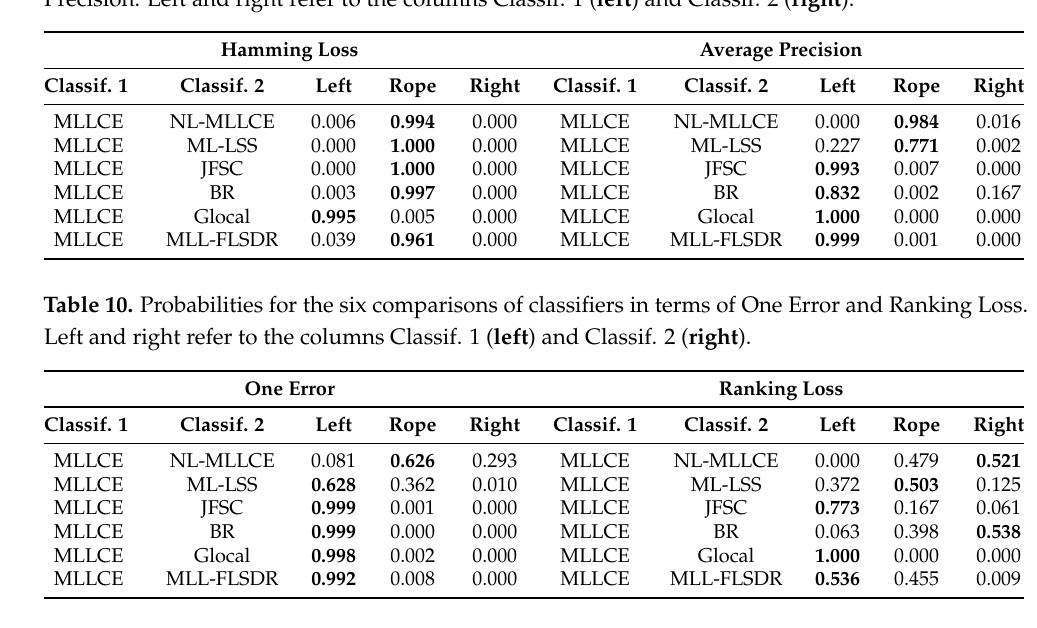
Table 11. Probabilities for the six comparisons of classifiers in terms of AUC and Micro F1. Left and right refer to the columns Classif. 1 ( left ) and Classif. 2 ( right ). AUC Micro F1 Classif. 1 Classif. 2